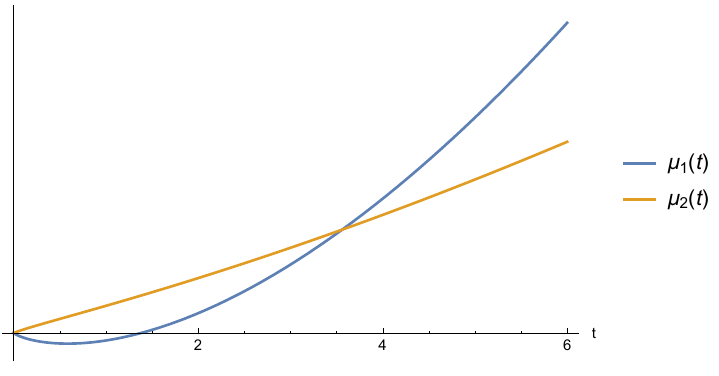
Fig. 13 The solutions of the initial value problem 40–41 for α = 0 . 8